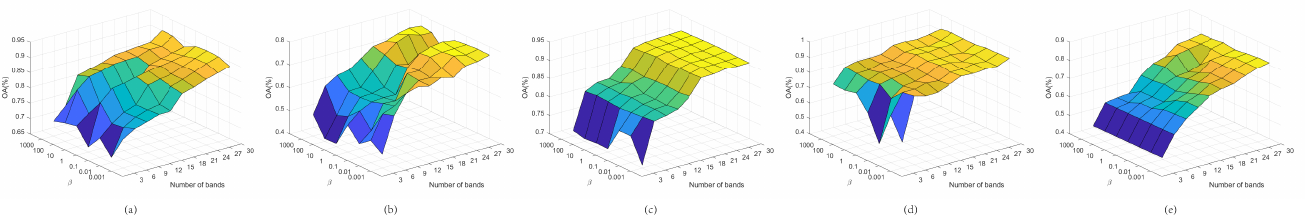
Figure 12. The sensitivity of hyperparameter α on the five datasets. ( a ) Pavia University; ( b ) Indian Pines; ( c ) Salinas; ( d ) Botswana; ( e ) Houston University.